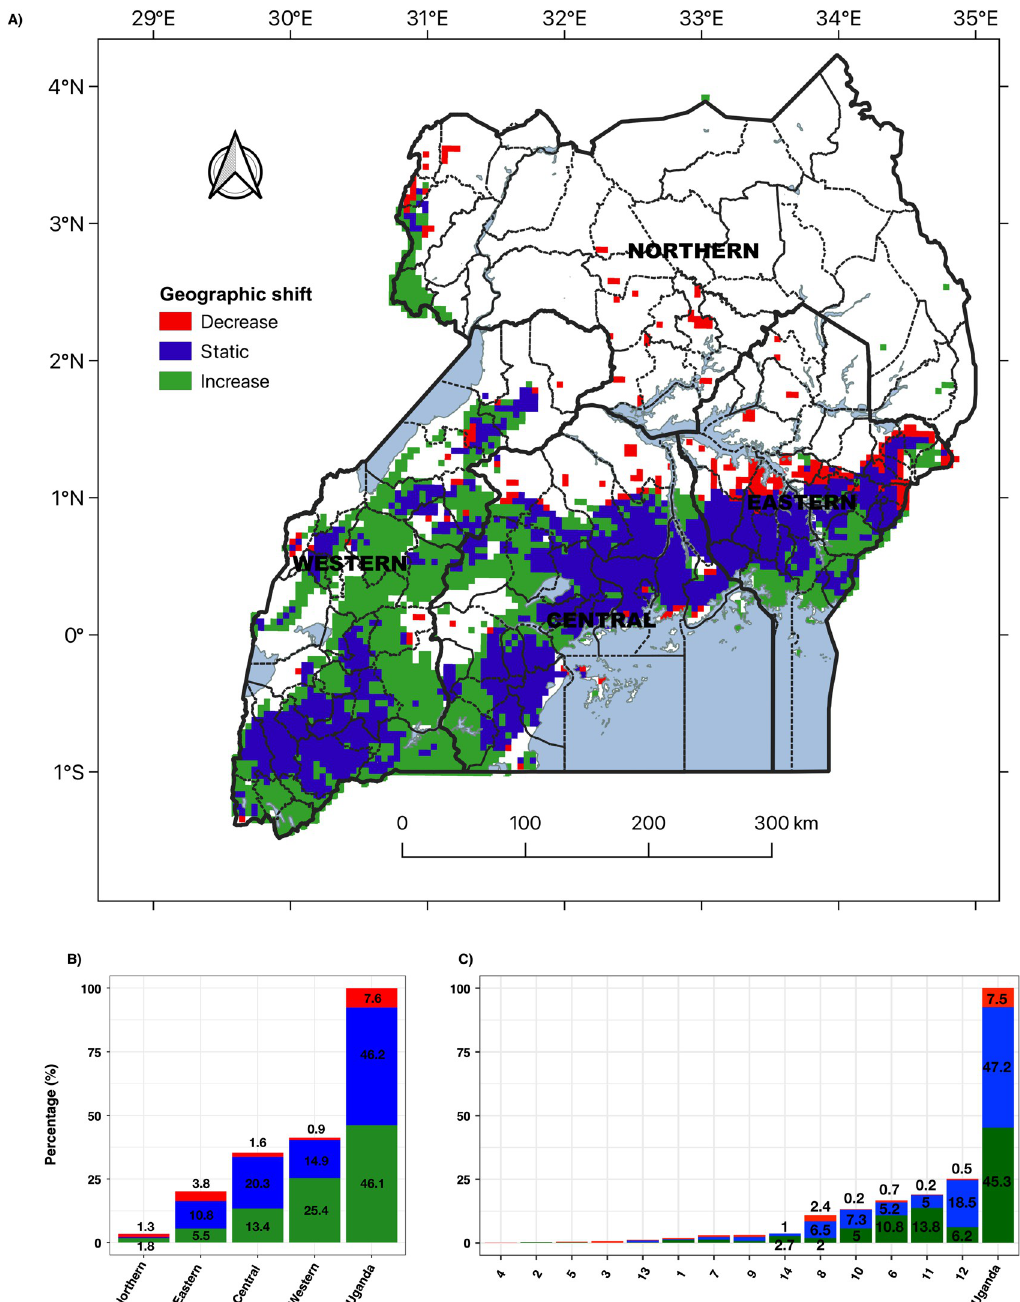
Fig 10. Geographic shifts of banana in Uganda. A) geographic shift patterns generated by overlaying the historical distributions (1958) and latest banana distribution (2016); B) percentage distribution of banana geographic shift between administrative regions: Northern, Eastern, Central and Western; C) percentage distribution of banana geographic shift among agroecological zones 1: West Nile Farmlands; 2: Northwestern Farmlands-Wooded-Savanna; 3: Northern Moist Farmlands; 4: Northeastern Central Grass-Bush Farmlands; 5: Northeastern Semi-arid Short Grass Plains; 6: Western Mid-Altitude Farmlands and the Semuliki Flats; 7:Central Wooded Savanna; 8: Southern and Eastern Lake Kyoga Plains; 9: Mount Elgon Farmlands; 10: Western Medium High Farmlands; 11: Southwestern Grass Farmlands; 12: Lake Victoria Crescent and Mbale Farmlands; 13: Ssese Islands and Sango Plains; 14: Southwestern Highlands. The percentages were computed based on numbers of pixels in each region that correspond to the different shift categories divided by the total number of pixels in the geographic shift map of Uganda.